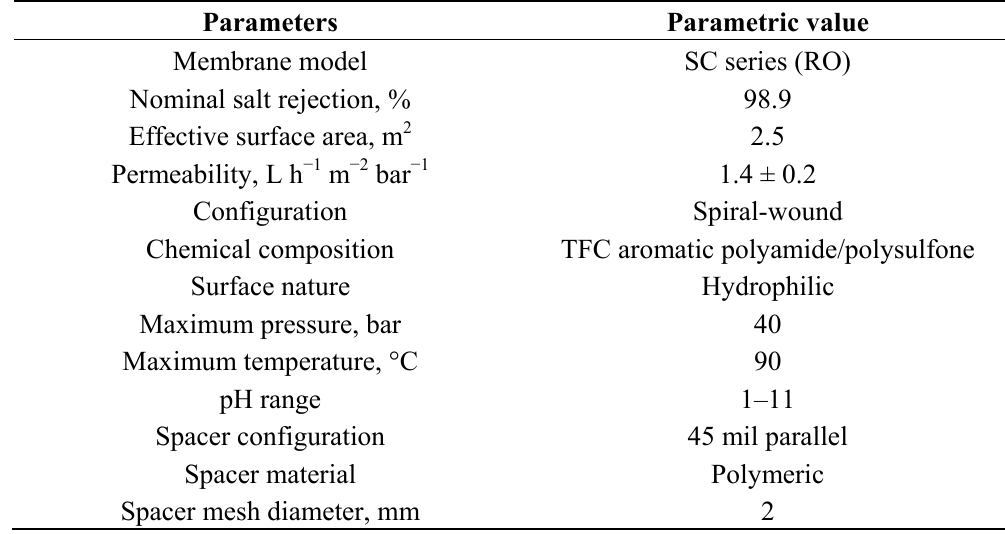
Table 3. Membrane